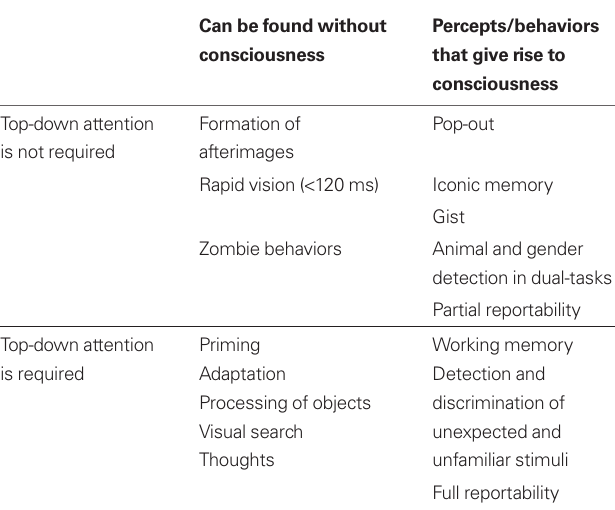
Table 1 | A four-fold classification of percepts and behaviors depending on whether or not top-down attention is necessary and whether or not these percepts and behaviors give rise to phenomenal consciousness. Different percepts and behaviors are grouped together according to these two, psychophysically defined,